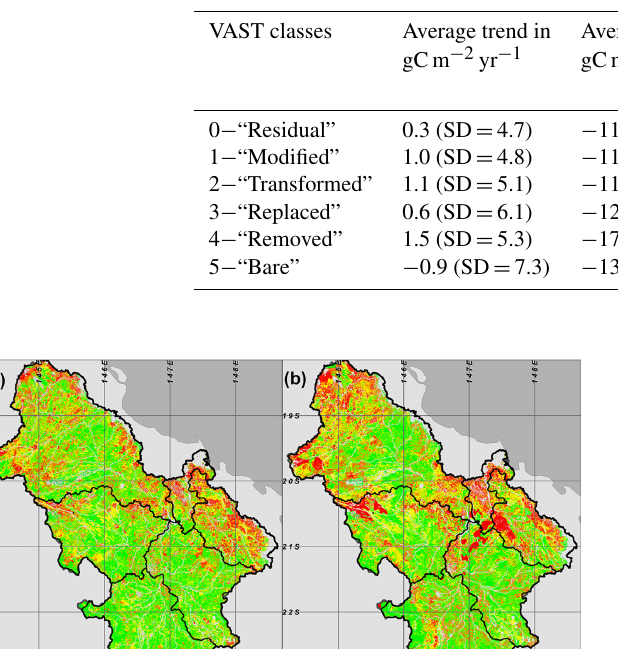
Table 8. VAST class comparison with interannual trends in LNS and average LNS. SD – standard deviation.